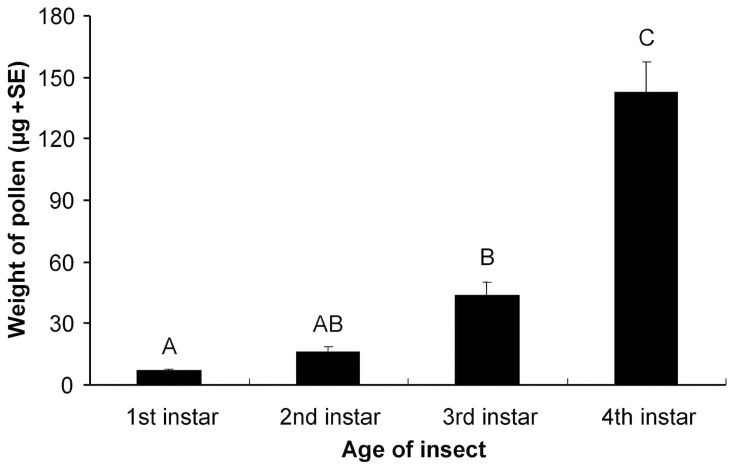
Consumption of rape seed pollen by Propylea japonica larvae.Larvae were fed exclusively with pollen for one day and the amount of pollen consumed is shown as weight of pollen per insect gut (mean+SE). Different letters above bars indicate significant differences (Tukey HSD test) (n = 7–10).